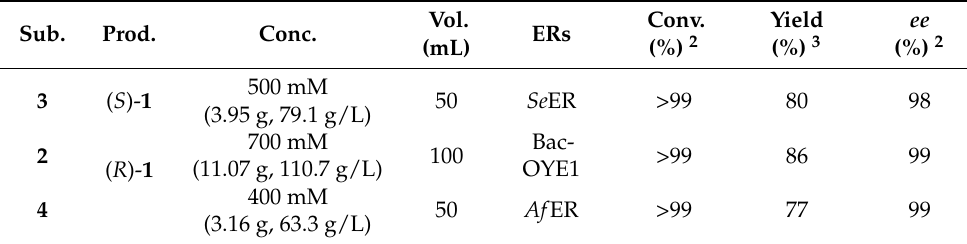
Table 4. Preparative-scale synthesis of ( R / S )- 1 1 . Sub.